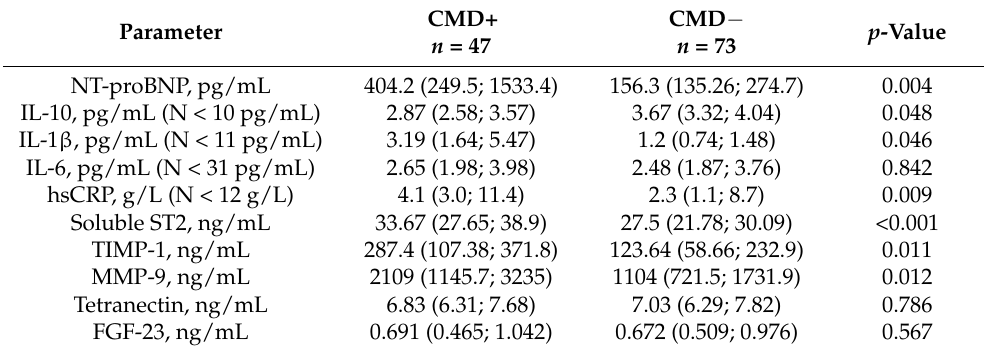
Table 3. The baseline levels of biomarkers.